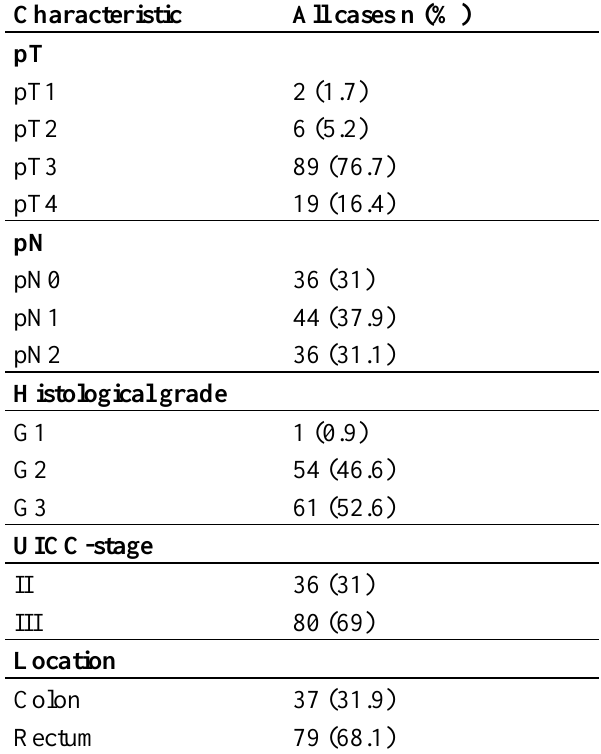
Table 1. Clinicopathological characteristics of 116 colorectal cancer patients.